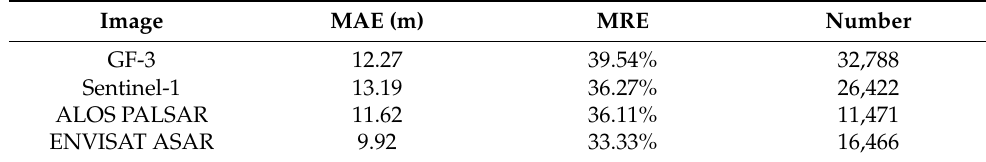
Table 3. The bathymetry error of different images.